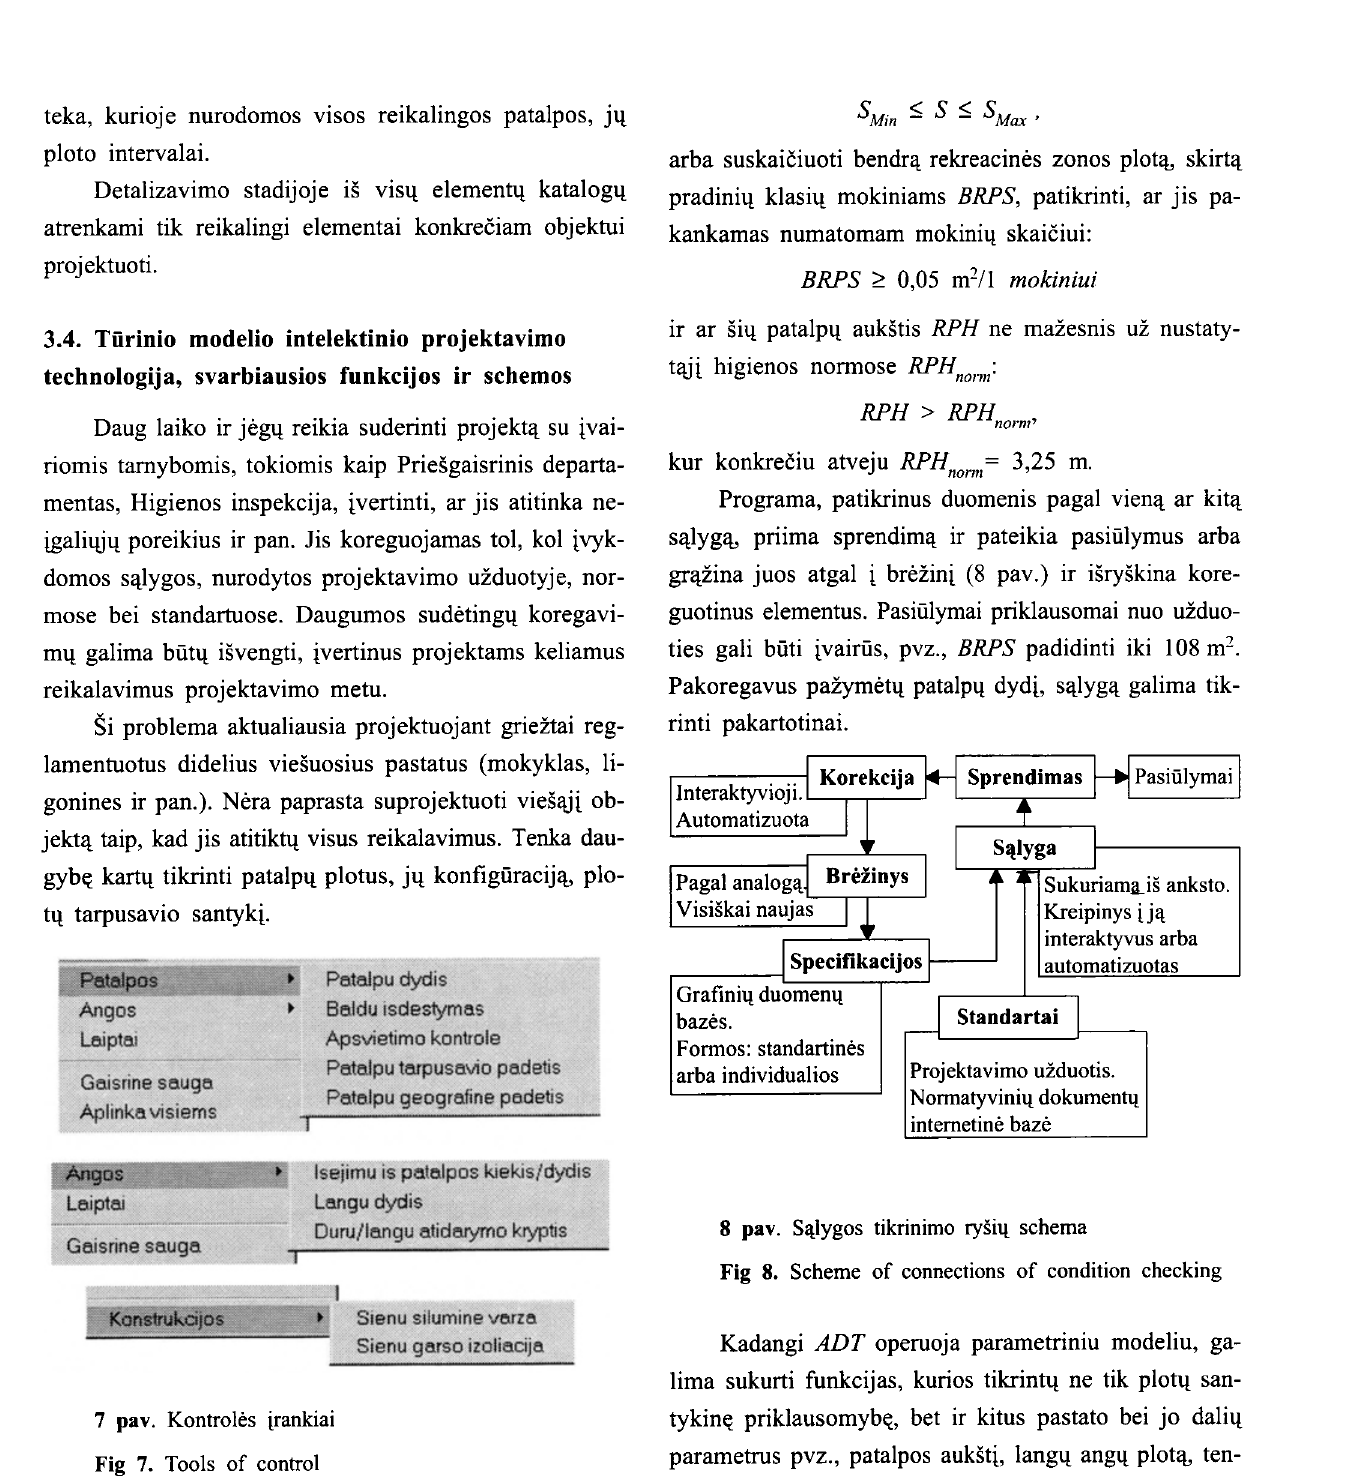
Fig 7. Tools of control